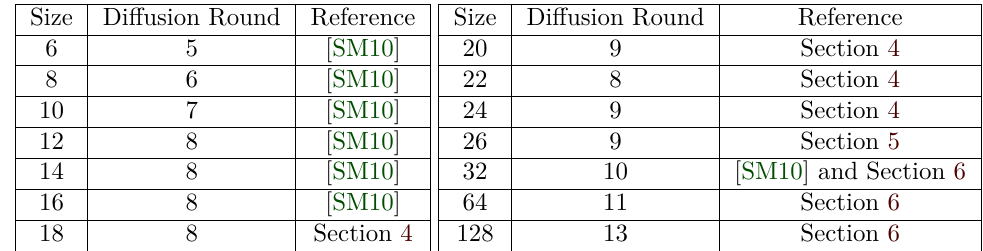
Table 1: Diffusion round of the best known